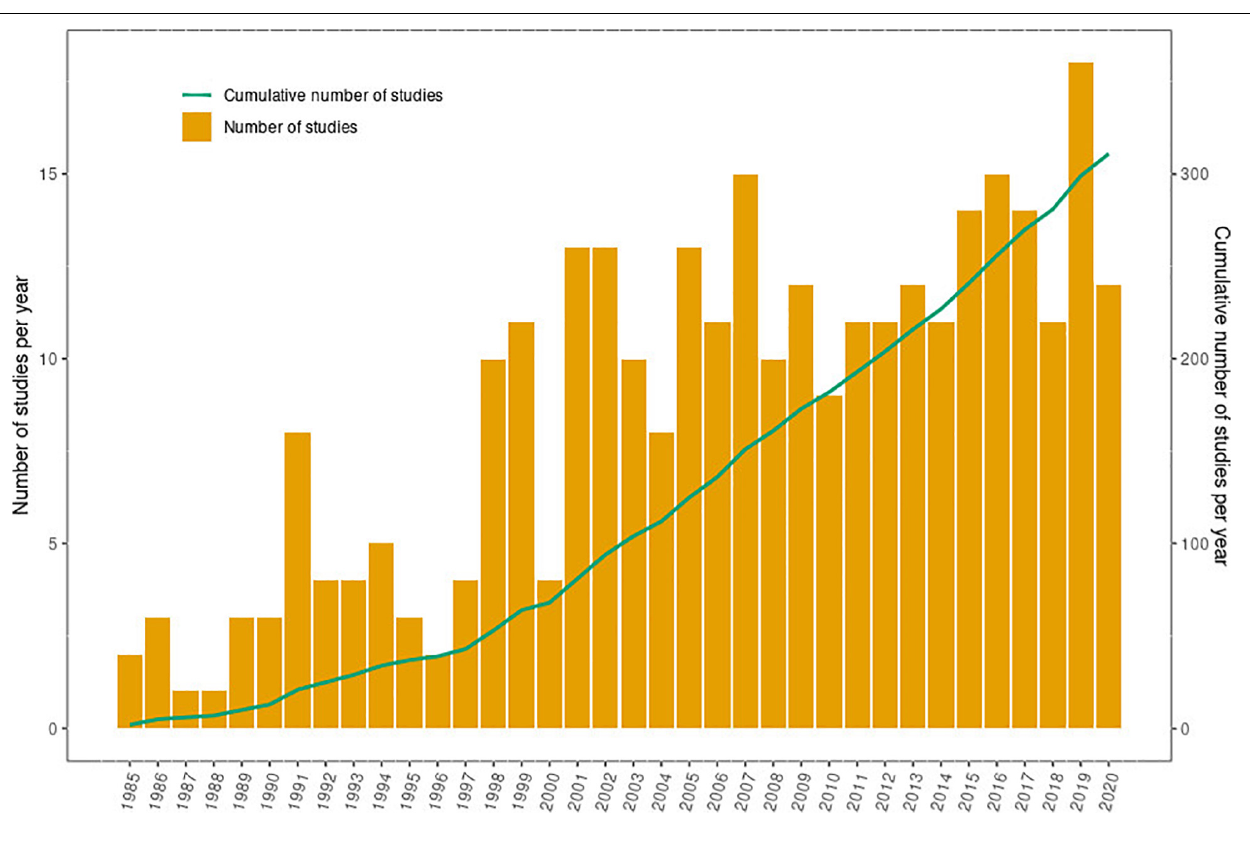
FIGURE 8 | Research effort on Old World bat-plant interactions during 1985-2020.